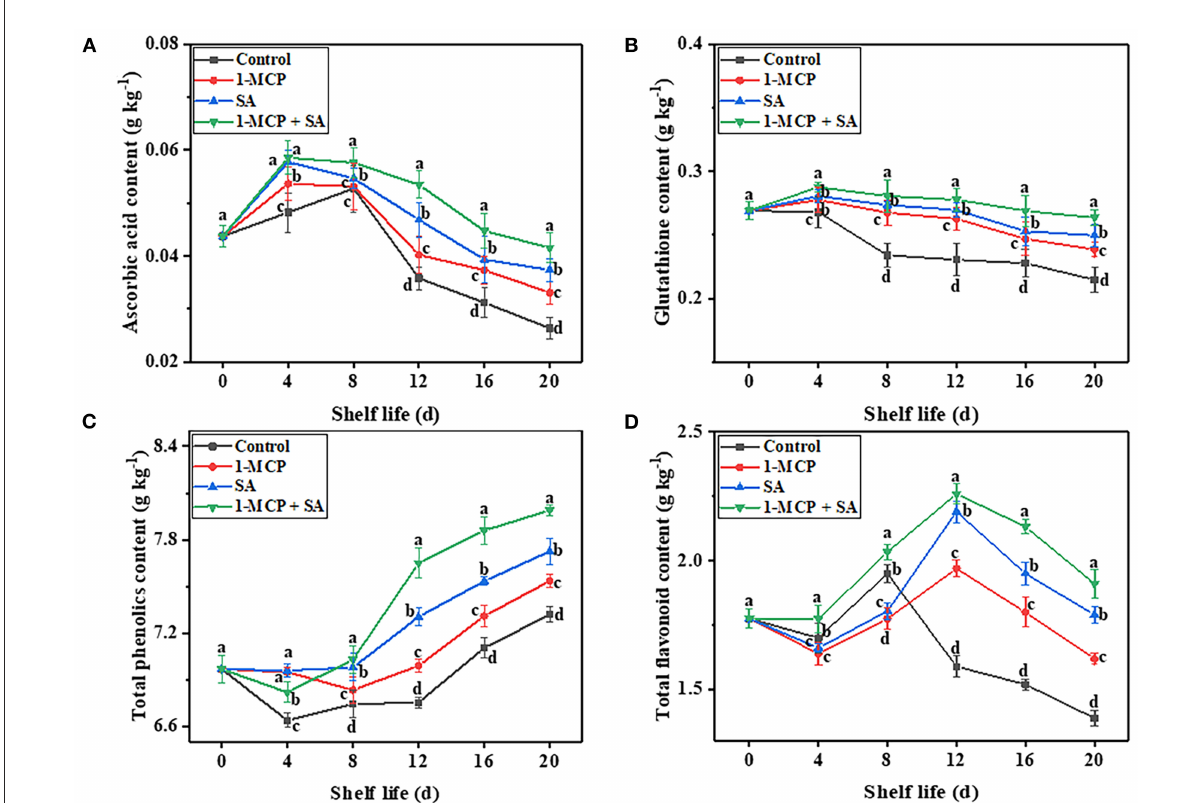
FIGURE6 Effects of 1-methylcyclopropene (1-MCP), salicylic acid (SA), and 1-MCP and SA combined treatments on ascorbic acid content (A) , glutathione content (B) , total phenolics content (C) , and total flavonoid content (D) of winter jujube fruit during shelf life at 4 ± 1 ◦ C for 20 d. The data presented are the mean values of three replicates; vertical bars represent the standard errors of the mean values; values followed by different superscripts (a-d) are significantly different ( P < 0.05) on the same sampling